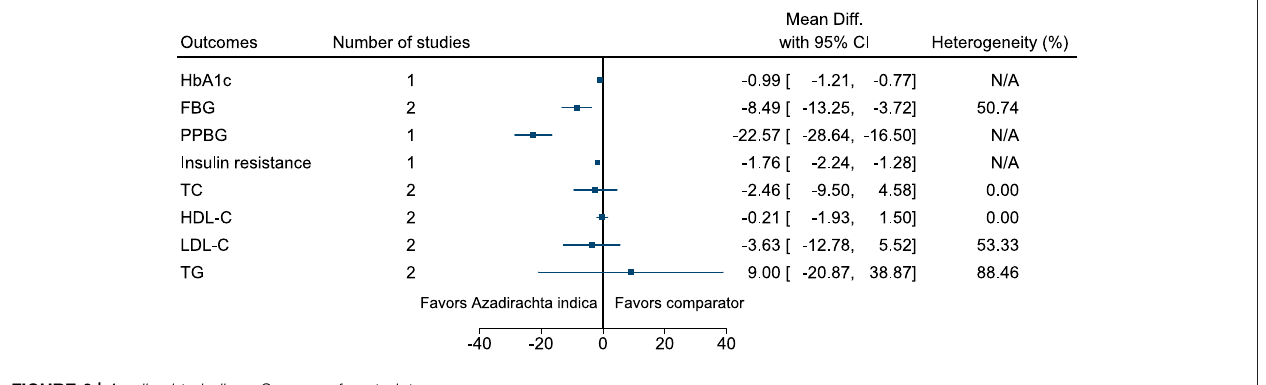
FIGURE 6 | Azadirachta indica - Summary forest